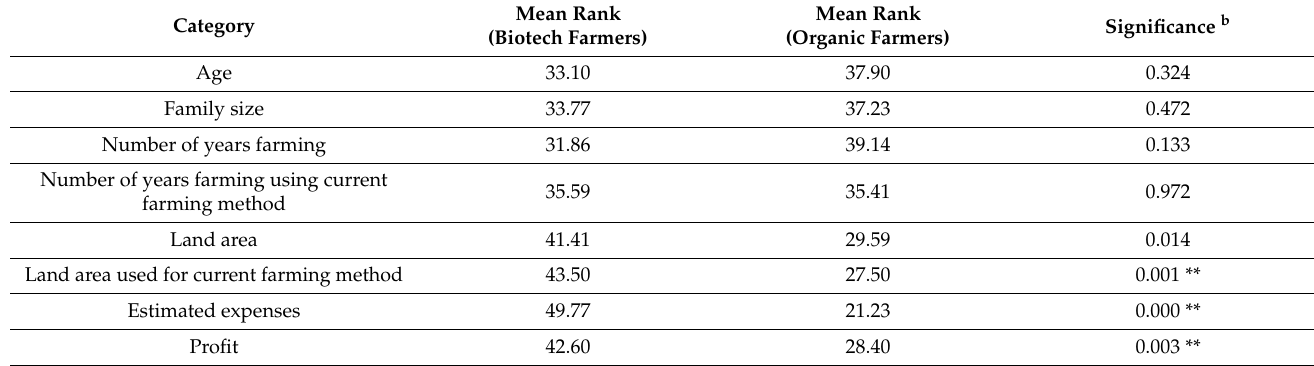
Table 3. Between-group comparison a of biotech farmers and organic farmers in terms of various socio-demographic and farm-related